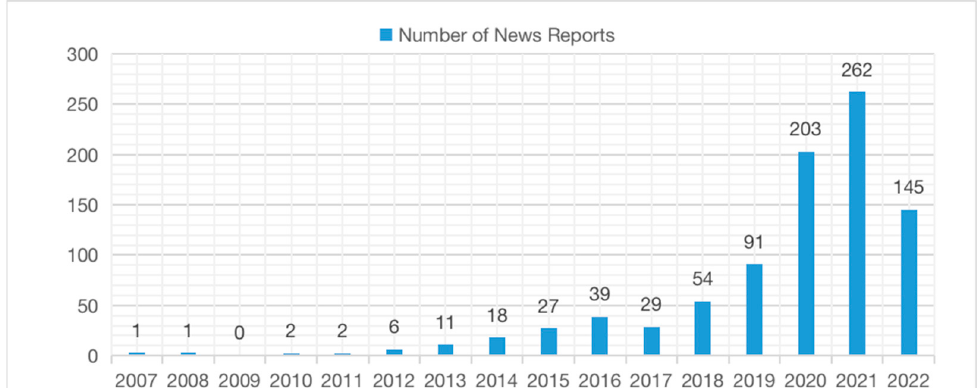
Figure 4. The number of news reports on RCC in China (2007–2022).